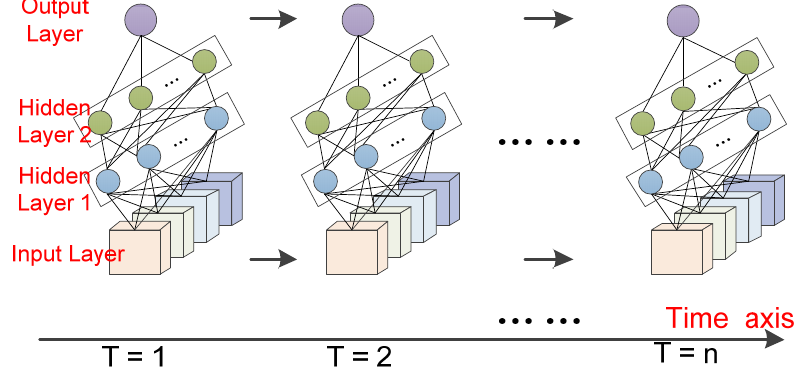
Figure 6. EDH nowcasting framework based on the LSTM network.